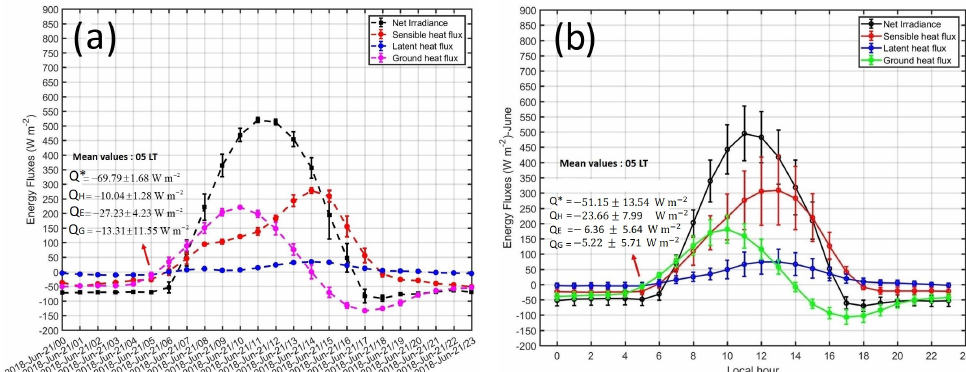
Figure 11. ( a ) Daily cycle of mean hourly values and standard deviations during 21 June 2018 of the energy balance components: net irradiance (Q ∗ ), sensible heat flux (Q H ), latent heat flux (Q E ) and ground heat flux (Q G ). The mean hourly values of all components at 05 LT are shown. ( b ) Daily cycle of mean monthly values and standard deviations during June 2018 of the energy balance components. The mean monthly values of all components at 05 LT are